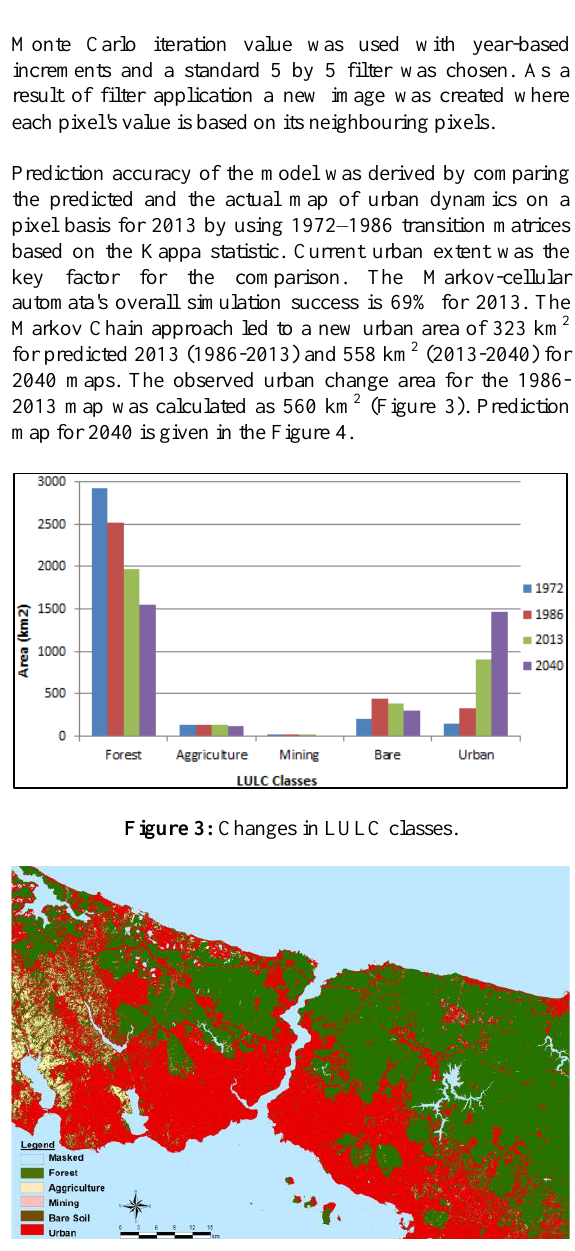
Figure 4: The result of the simulation for